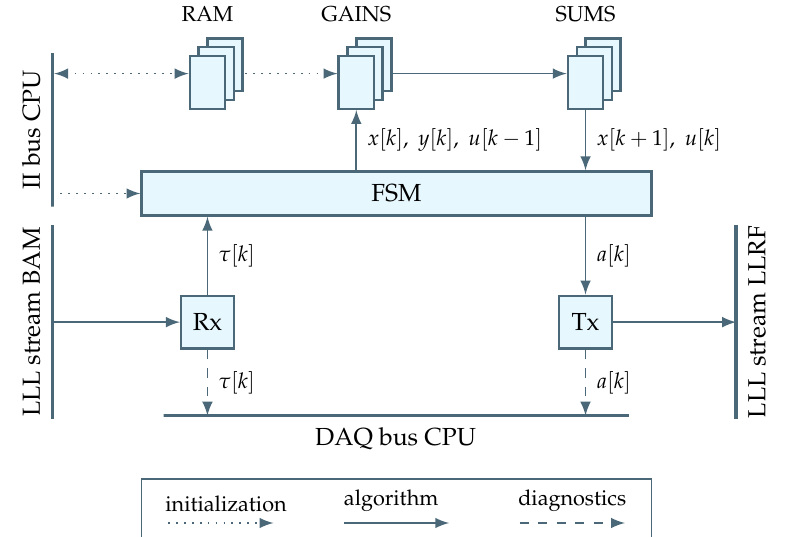
Figure 12. Functional schematic illustrating the main data flows inside the BBF